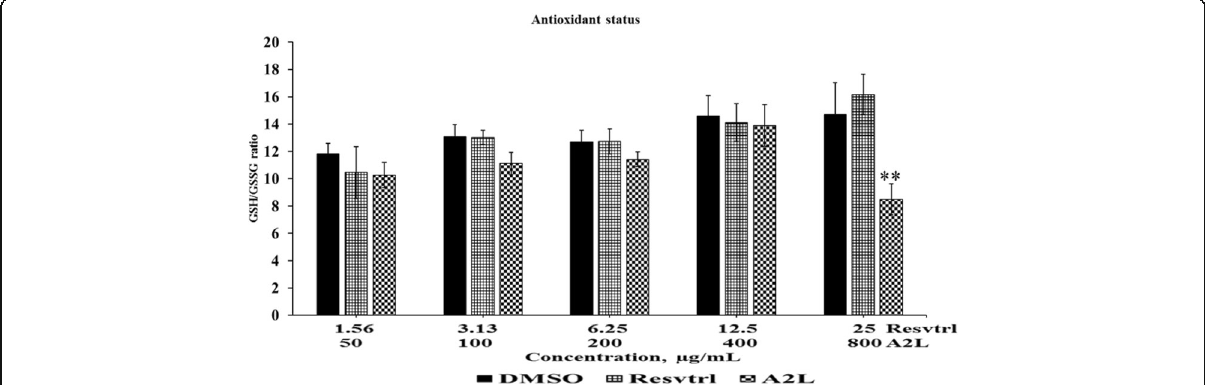
Fig. 9 Effects of treatment on anti-oxidant status. Anti-oxidant status (GSH/GSSG ratio) of HepG2 cells treated with resveratrol or A2L. ** p < 0.01